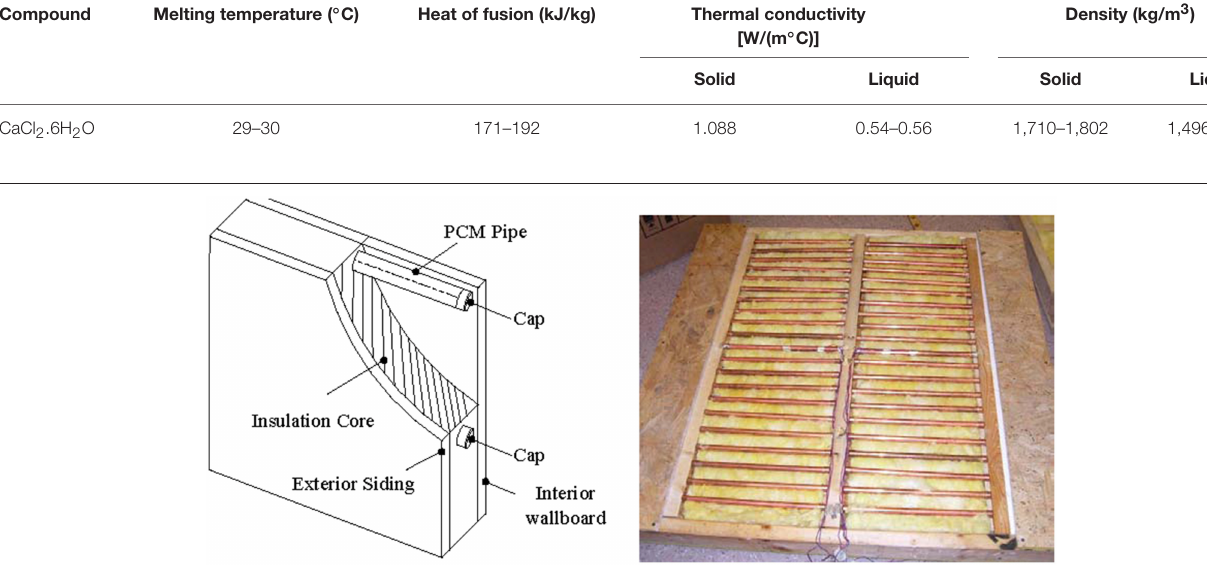
TABLE 1 | The thermal properties of calcium chloride hexahydrate (Zalba et al., 2003). Compound